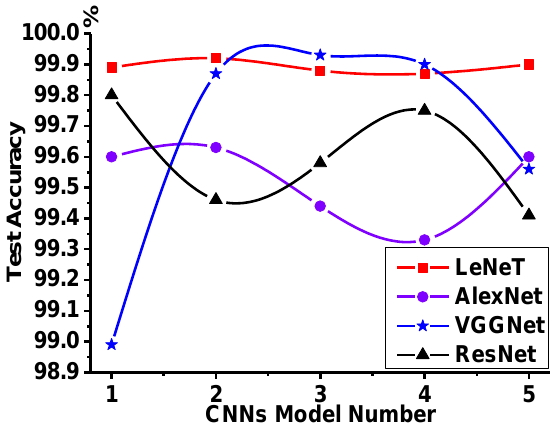
Figure 9. Generalization performance comparison of four CNNs.